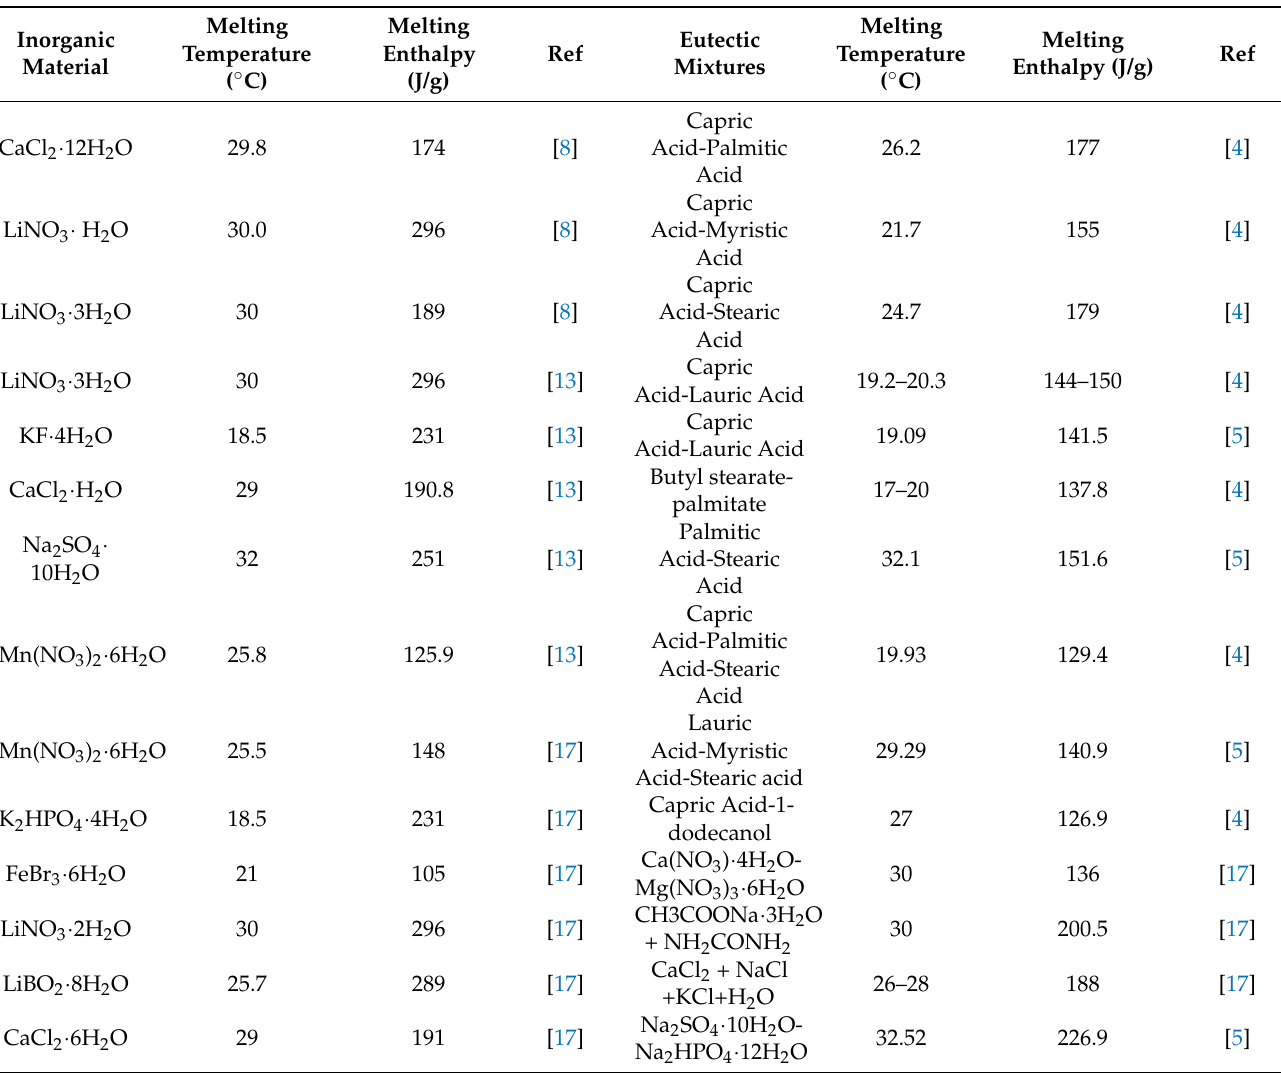
Table 4. Thermal properties of inorganic materials and eutectic mixtures used as